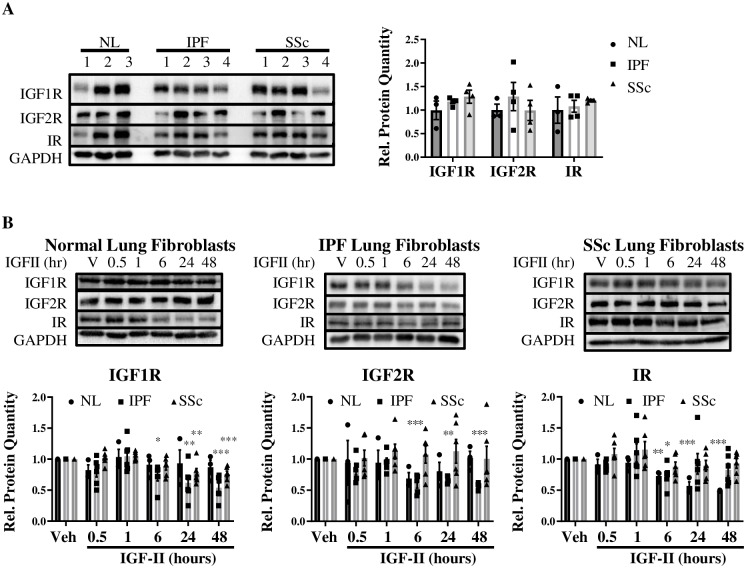
Steady-state and IGF-II-stimulated changes in receptor protein expression.Basal (A) and IGF-II (200 ng/mL)-stimulated protein expression of IGF1R, IGF2R, and IR receptors (B) in Normal Lung (NL), IPF, and SSc fibroblasts normalized to GAPDH housekeeping protein. Quantification of protein expression was graphed as histograms with mean +/- standard error of the mean and representative immunoblots included. N = 3–6. *p<0.05, **p<0.01, ***p<0.001 by paired 2-tailed Student’s T Test (A) and 1-way ANOVA with Dunnett’s multiple comparison test compared to vehicle (PBS, B).